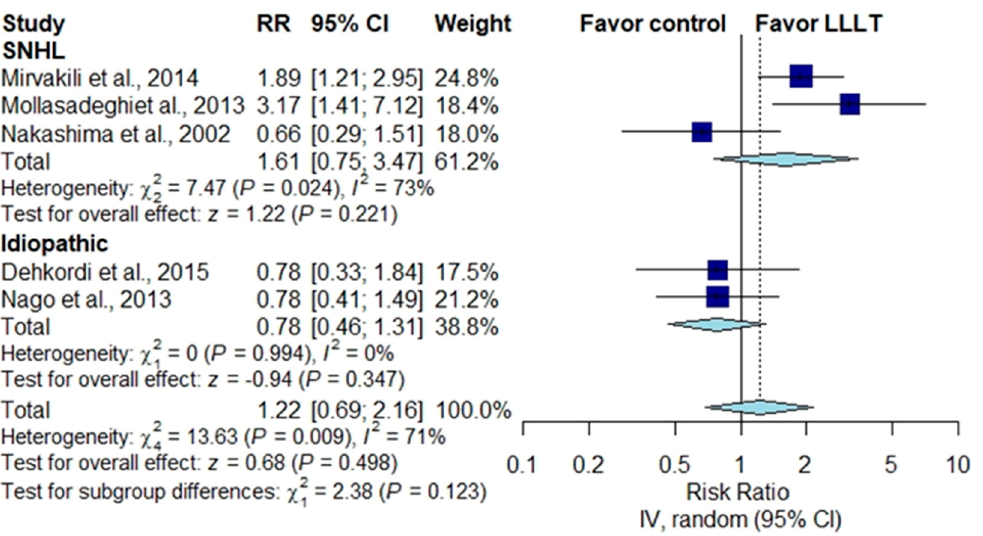
Figure 5. Subgroup analysis of rating scale score improvement in patients with SNHL and patients with idiopathic tinnitus [23–26,31].